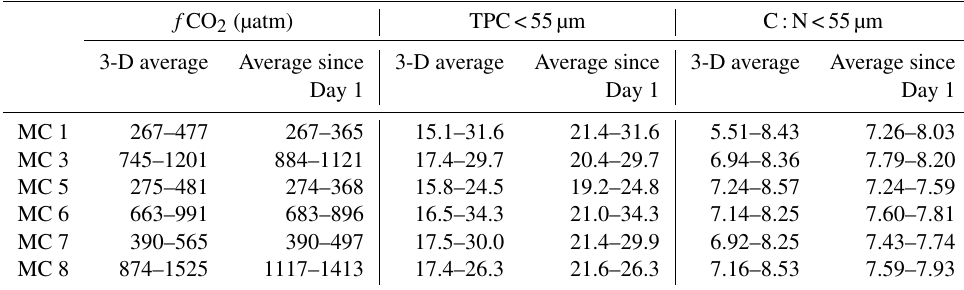
Figure 1. Development of Acartia bifilosa (a) egg production, (b) prosome length (average ± s.e.), (c) antioxidant capacity and (d) egg- hatching success in the mesocosms and (e) egg-hatching success in Baltic water when eggs are produced in mesocosms in the course of the study. The f CO 2 (µatm) values represent the average in days 1–43 (Paul et al., 2015). Table 3. Ranges of f CO 2 , TPC<55µm and C:N<55µm that were used as explanatory variables in the full LMM and GLMM models. Three-day averages (measured within the latest three days of the sampling day) were used for testing the effects of the explanatory variables on copepod EPR, ORAC and EH, whereas average of all measurements since the start of the experiments until the sampling day were used when testing the effects of the explanatory variables on copepod size (PL). Variations in f CO 2 , TPC<55µm, and C:N<55µm in the course of the study are presented in Paul et al.